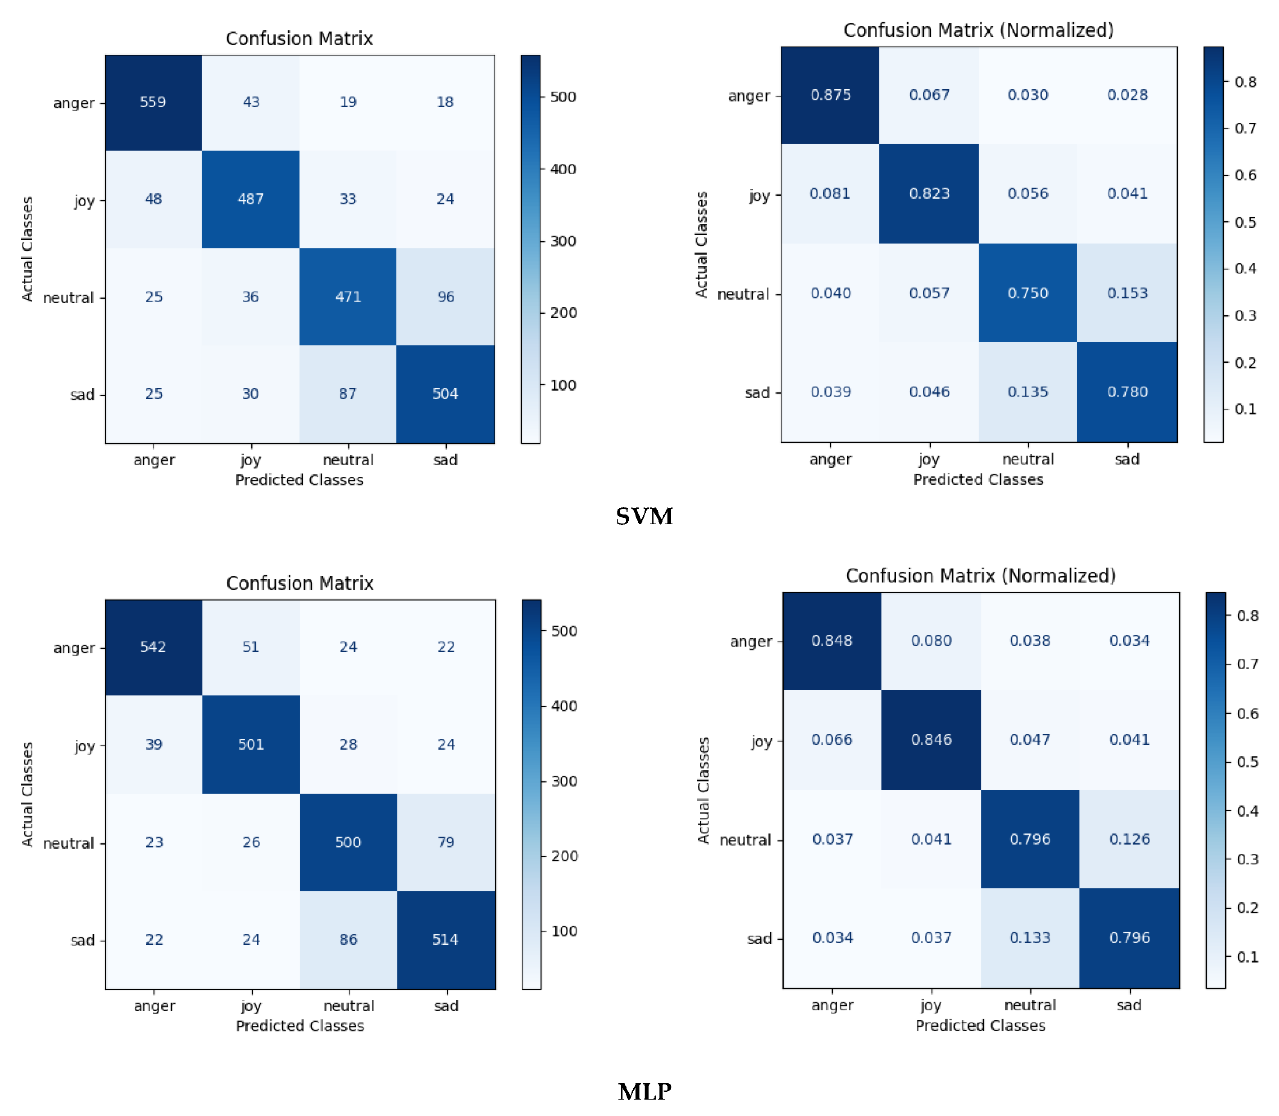
Figure 1. Confusion matrices for SVM and MLP classifiers, eGeMAPS feature set, a dataset of Russian children’ s emotional speech with 2505 samples for training and testing. Table 2. Per-class scores in multi-class classification, eGeMAPS feature set.